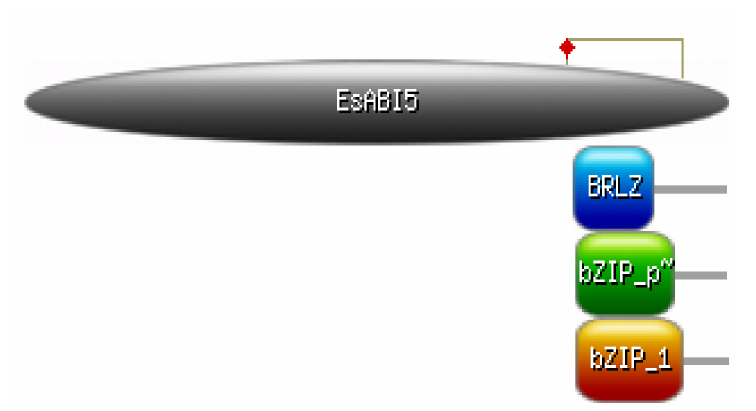
Figure 1. Coil analysis of EsABI5 protein.